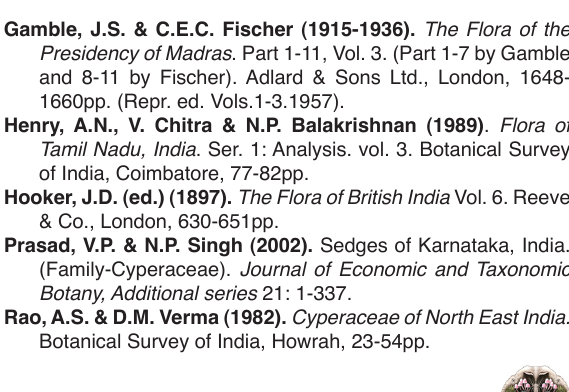
cm long, reddish-brown, pedicelled, rarely 1 or 2 spikelets sessile, 6-10(13) flowered; pedicel 2.5-7.5 mm long; involucral bracts 3-5, rarely 8, 0.8-2 cm long, equal to or longer than spikelets, setaceous from broad base, scabrid at base, sharply spinulose scabrid towards apex, shortly and suddenly pointed at apex. Rachilla narrowly winged.